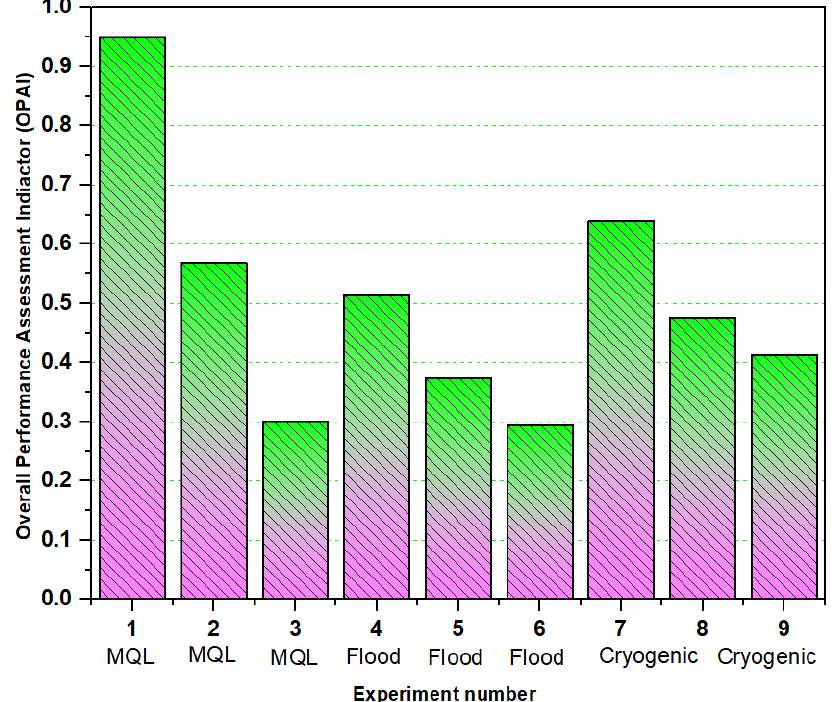
Figure 6. Weighted sustainability index of cryogenic LN 2 -assisted machining for case study 3.